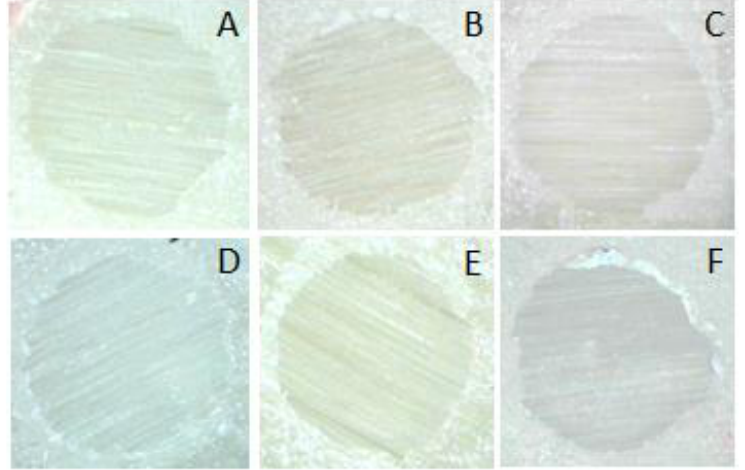
Figure 2 . Adhesive failure mode illustrating; ( A ) group 1; ( B ) group 2; ( C ) group 3; ( D ) group 4; ( E ) group 5; and ( F ) group 6